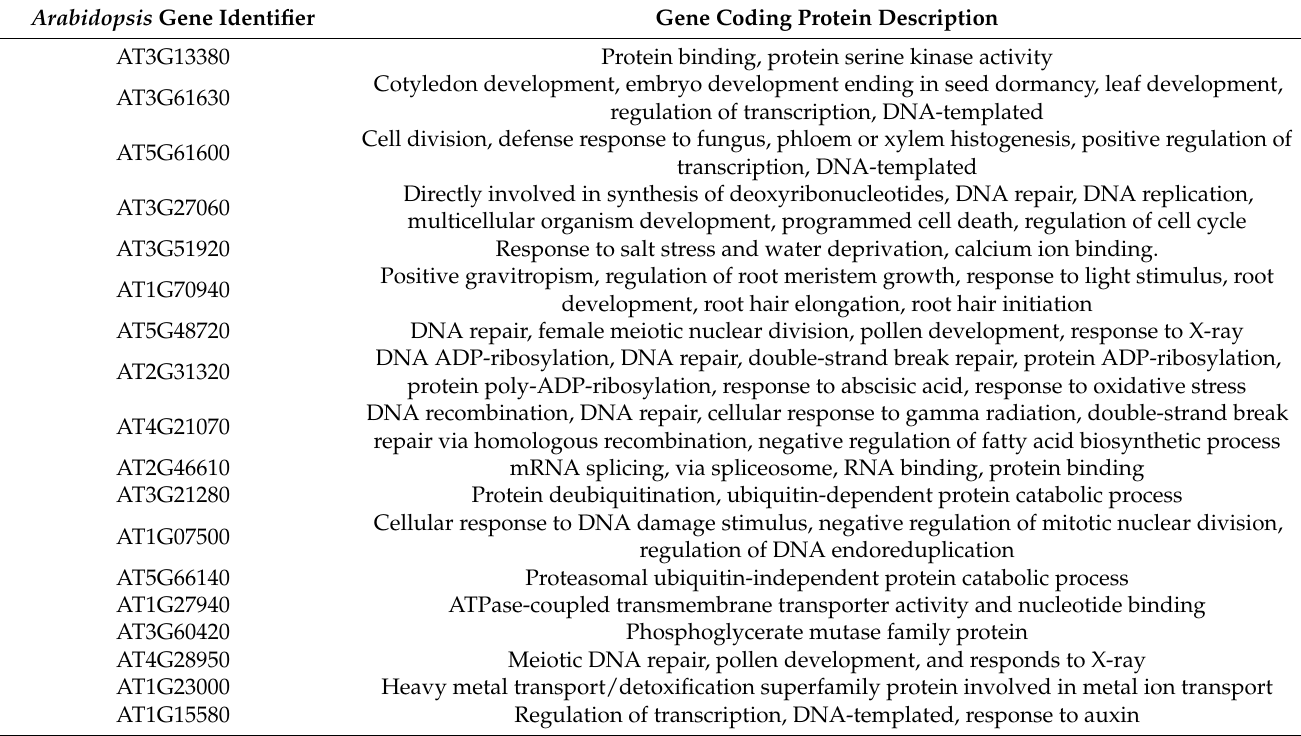
Table 8. Key ATR/ATM radiation-induced genes identified from the DDR process subnetworks. Arabidopsis Gene Identifier Gene Coding Protein Description AT3G13380 Protein binding, protein serine kinase activity